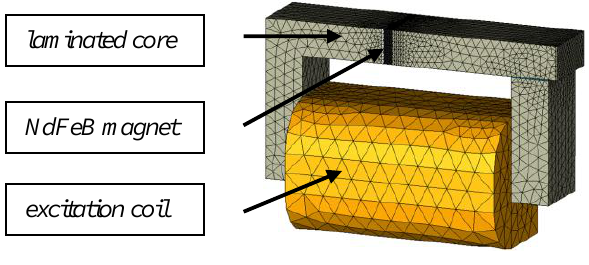
Figure 2. FE mesh of ¼ of the experimental device.